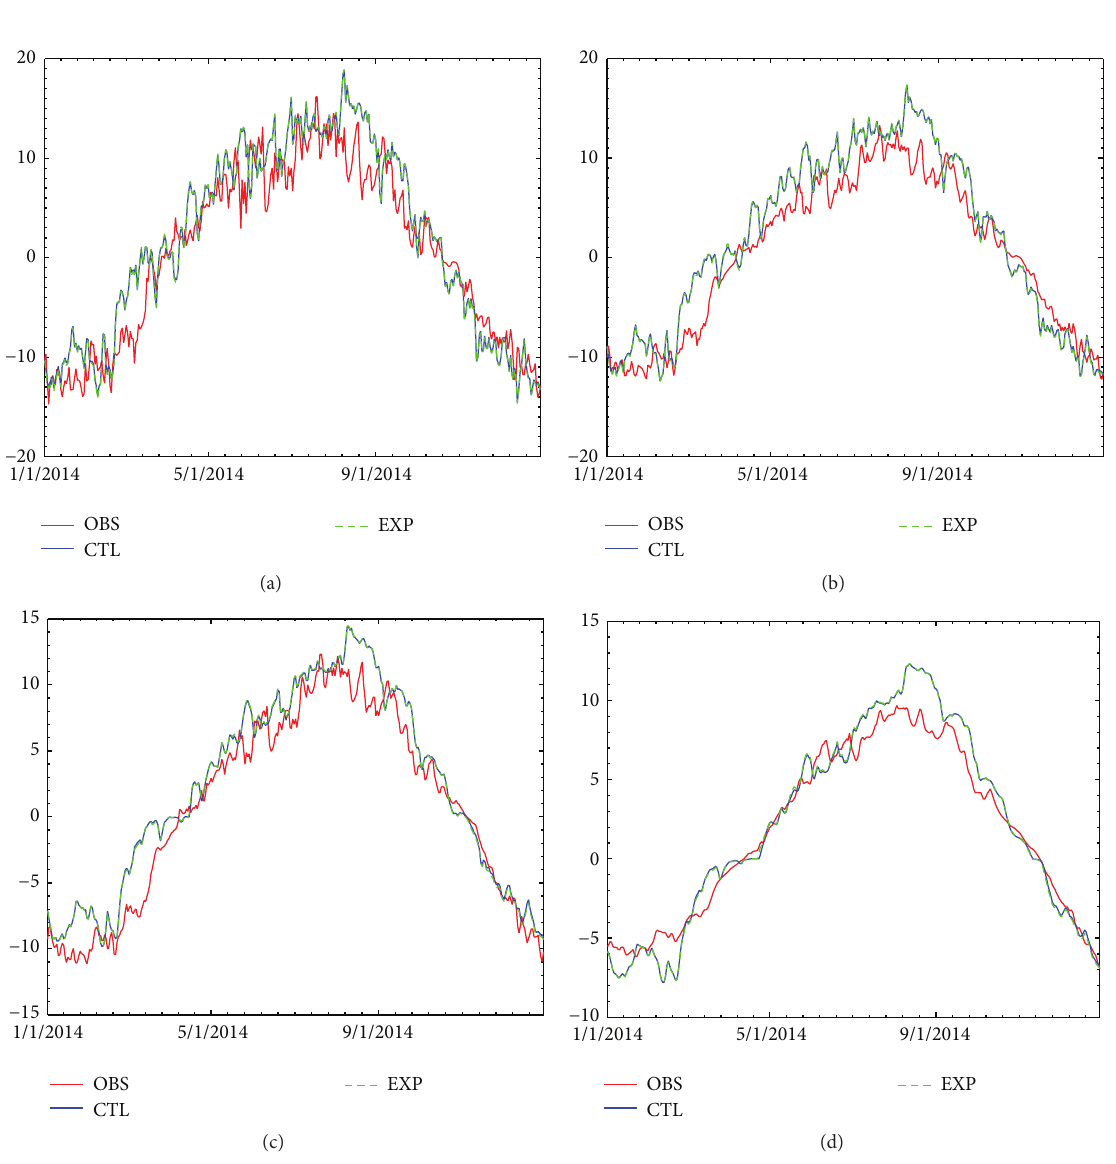
Figure 8: Daily average soil temperature ( ∘ C) at (a) 5 cm, (b) 20 cm, (c) 40 cm, and (d) 80cm at GS